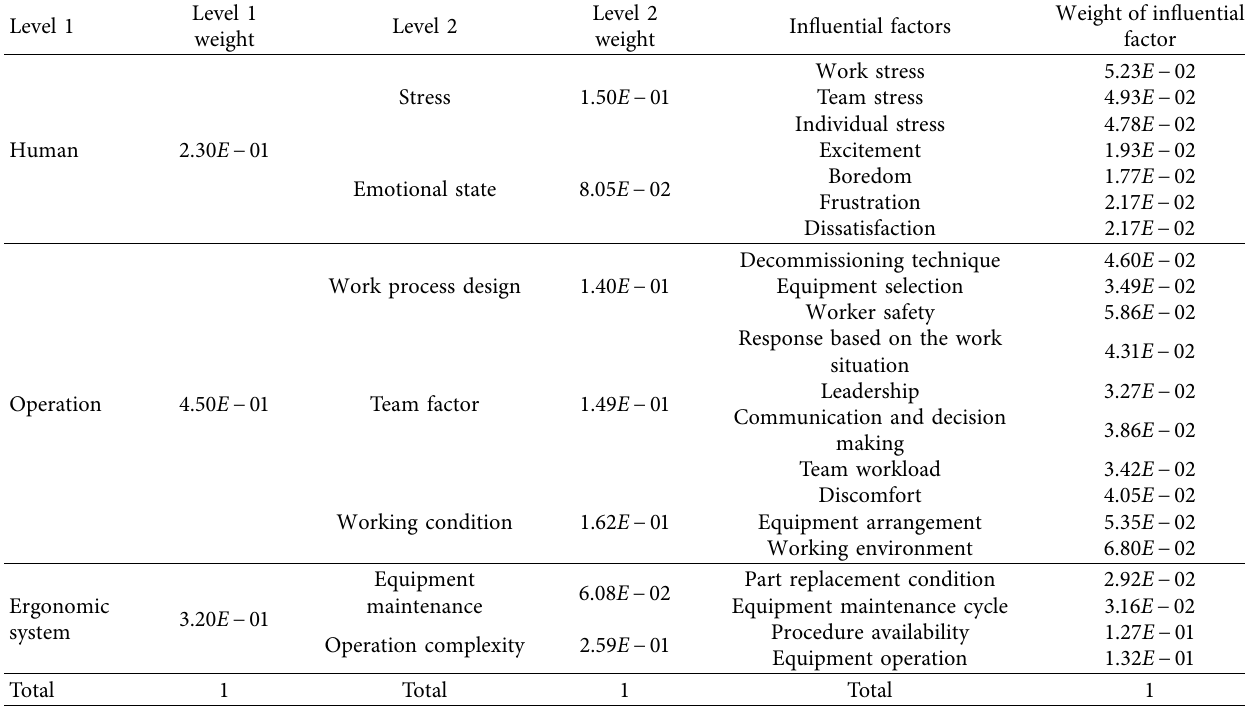
Table 2: Importance of the PSFs for NPP decommissioning derived through the